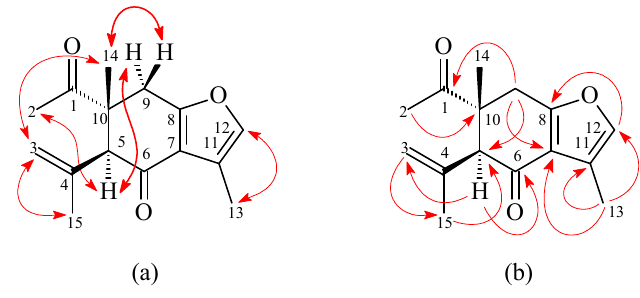
Figure 4. Key ( a ) NOESY and ( b ) HMBC correlations of 2 .